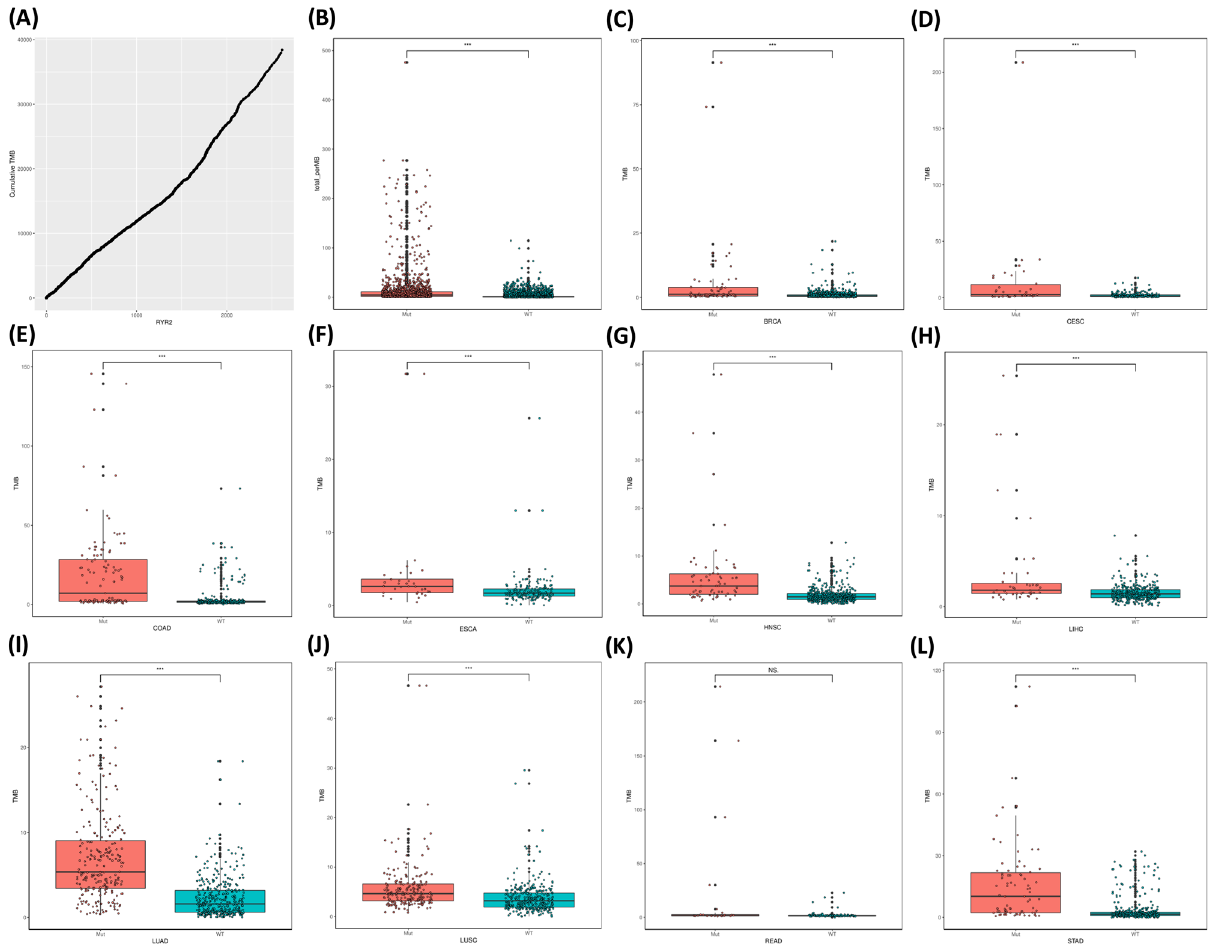
Figure 4. The correlation between RYR2 mutational status and tumor mutational burden (TMB). ( A ) The correlation between cumulative number of mutations (X-axis) and cumulative TMB (Y-axis) in RYR2. ( B ) Scatter plot of TMB grouped by RYR2 mutational status (mutant or WT) in all types of cancers. ( C – L ) Scatter plot of TMB grouped by RYR2 mutational status (mutant or WT) in each type of cancer, as indicated. *P < 0.05; **P < 0.01; ***P <